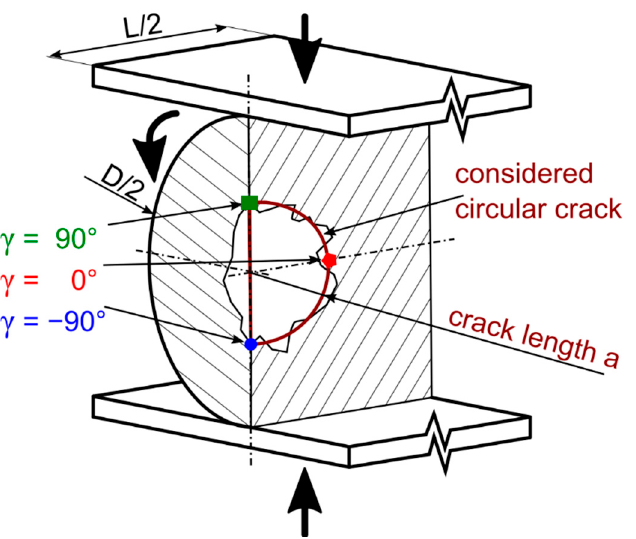
Figure 1. The situation of the bearing cylinder with an internal defect, compressed between two steel plates and rolling. plates and